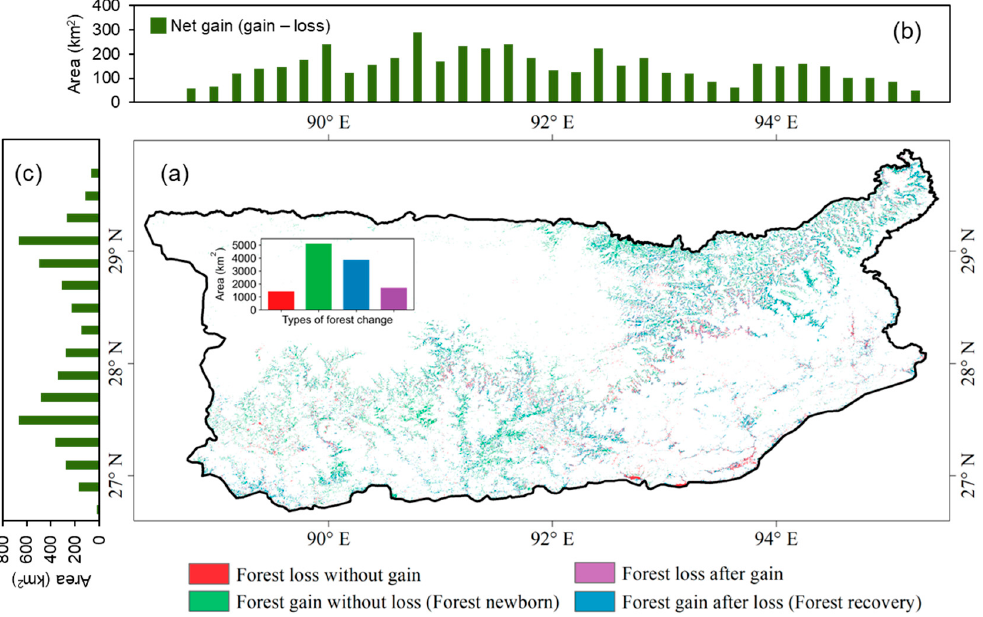
Figure 11. ( a ) Spatial distribution of four kinds of forest changes in 1990–2020 and area statistics along longitude ( b ) and latitude ( c ) of net gain.